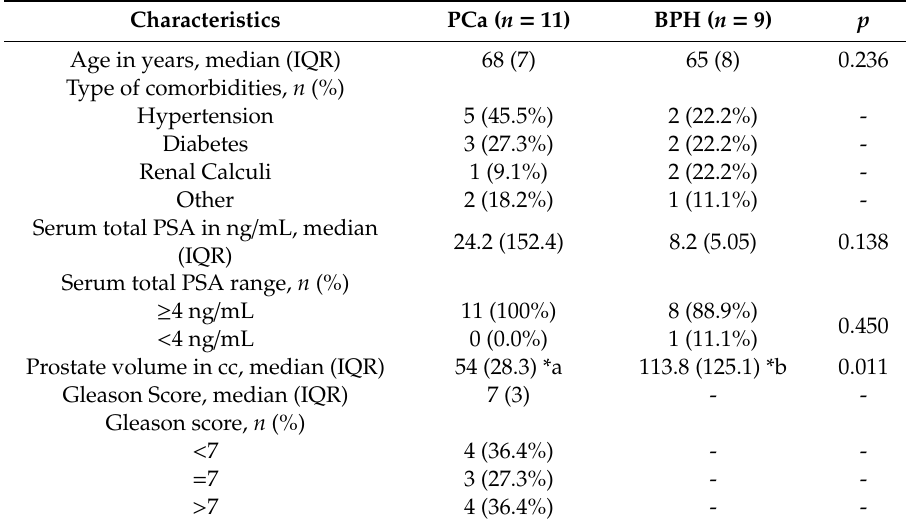
Table 1. Patient characteristics.